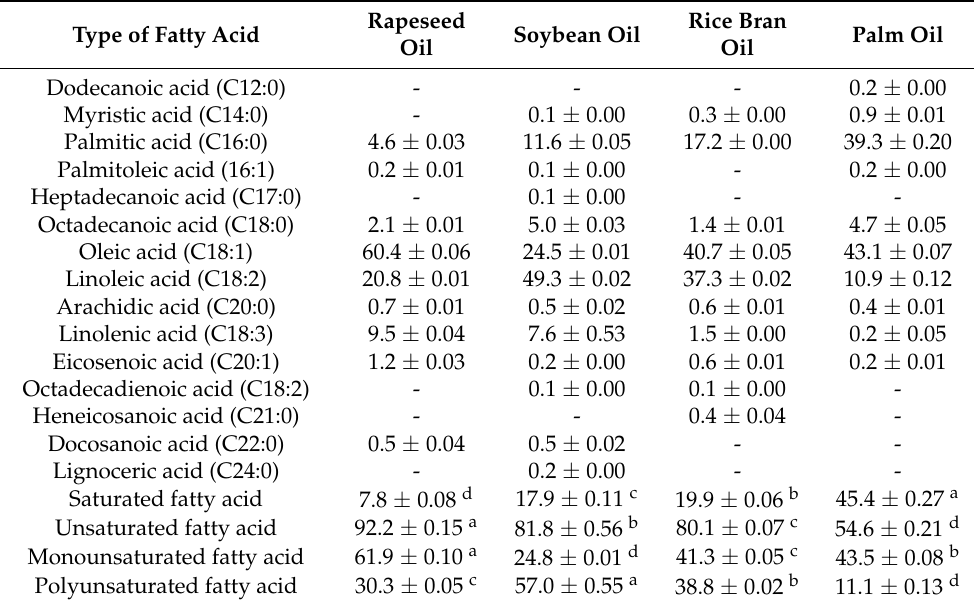
Table 1. Fatty acid compositional estimation (relative percentage of the chromatographic areas) of fresh frying oils †.